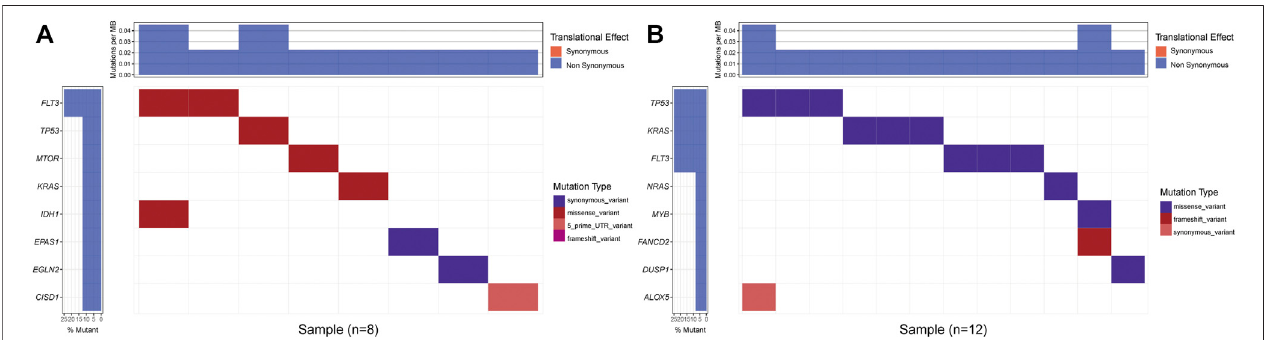
FIGURE 9 | Mutation status of the prognostic model. (A) Low- and (B) High-risk groups mutation status.